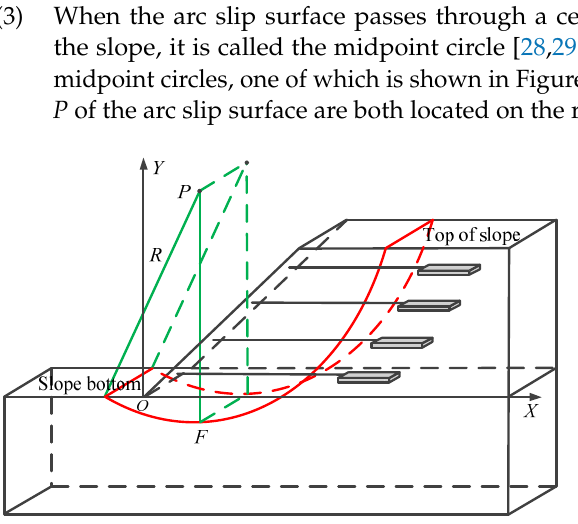
Figure 7. Schematic diagram of slope toe circle 2.